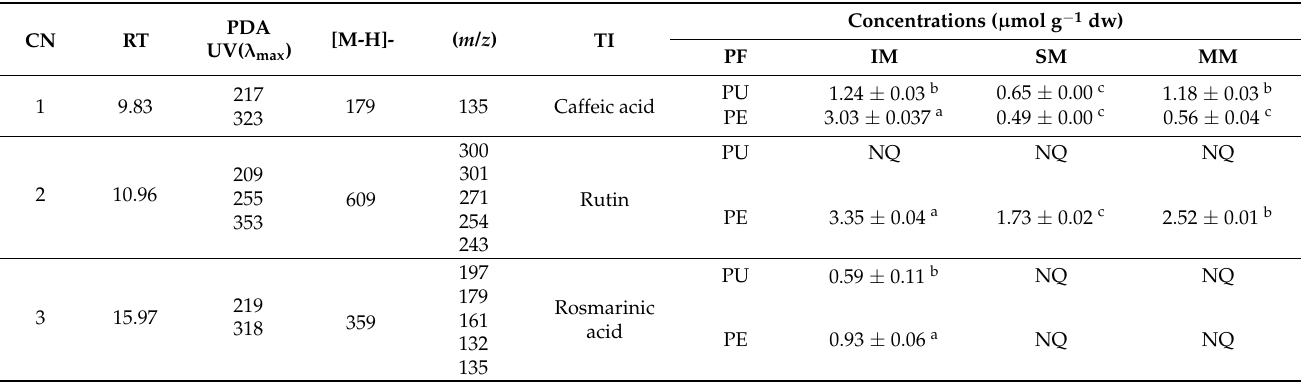
Table 3. Main phenolic compounds identified by UPLC-DAD-ESI-MS/MS in extracts of Cordia dodecandra A. DC.